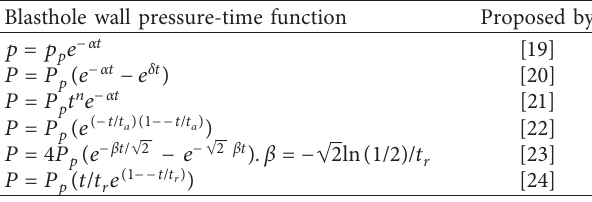
Table 1: Some important blasthole wall pressure-time functions. Blasthole wall pressure-time function Proposed